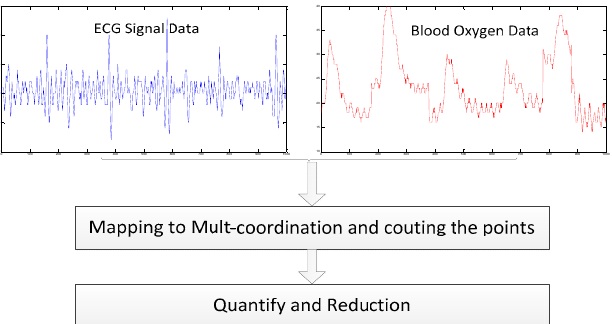
Figure 1. Flow of hybrid ECG and blood oxygen identification with QSMI algorithm.